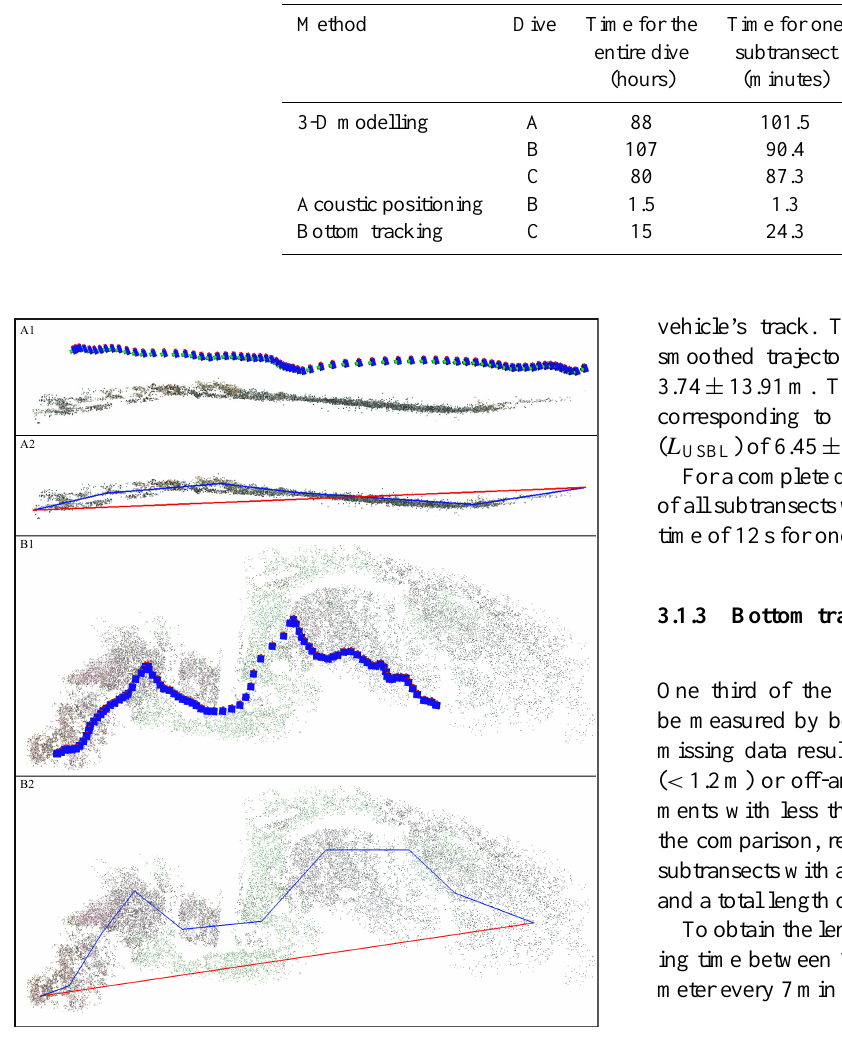
Fig. 6. 3-D models and subtransect length. (A) Example of a recon- structed ROV subtransect in the Antarctic seen in lateral view. (B) Example of a reconstructed ROV subtransect in Chile displayed in top-front view and showing the complex topography. (1) 3-D points cloud and camera positions. (2) 3-D points cloud, linear subtransect length ( L 3Dl , red line) and projected subtransect length ( L 3Dp , blue